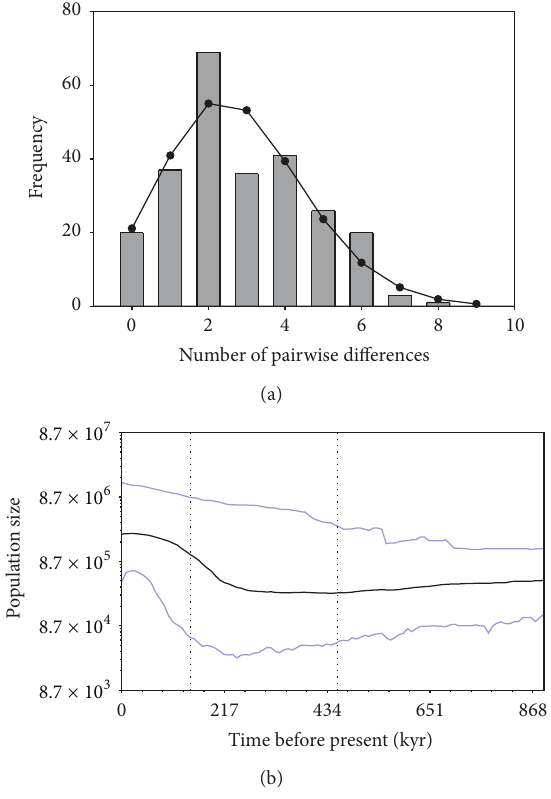
Figure 4: Demographic history of Culex tarsalis from the Sonoran Desert inferred from the mismatch distribution (a) and Bayesian skyline analysis (b). Vertical bars of the mismatch distribution show the observed distribution of pairwise differences among COI haplotypes,withthesolidlinerepresentingtheexpecteddistribution under the sudden expansion model. The Bayesian skyline plot shows the estimated changes in effective female population size ( 𝑁 time given on a logarithmic scale. The solid lines represent the median estimates of population size (middle line); upper and lower lines show the 95% highest posterior density (HPD) intervals. The vertical dotted lines represent the median estimate (right) and lower 95% HPD (left) of time to the most recent common